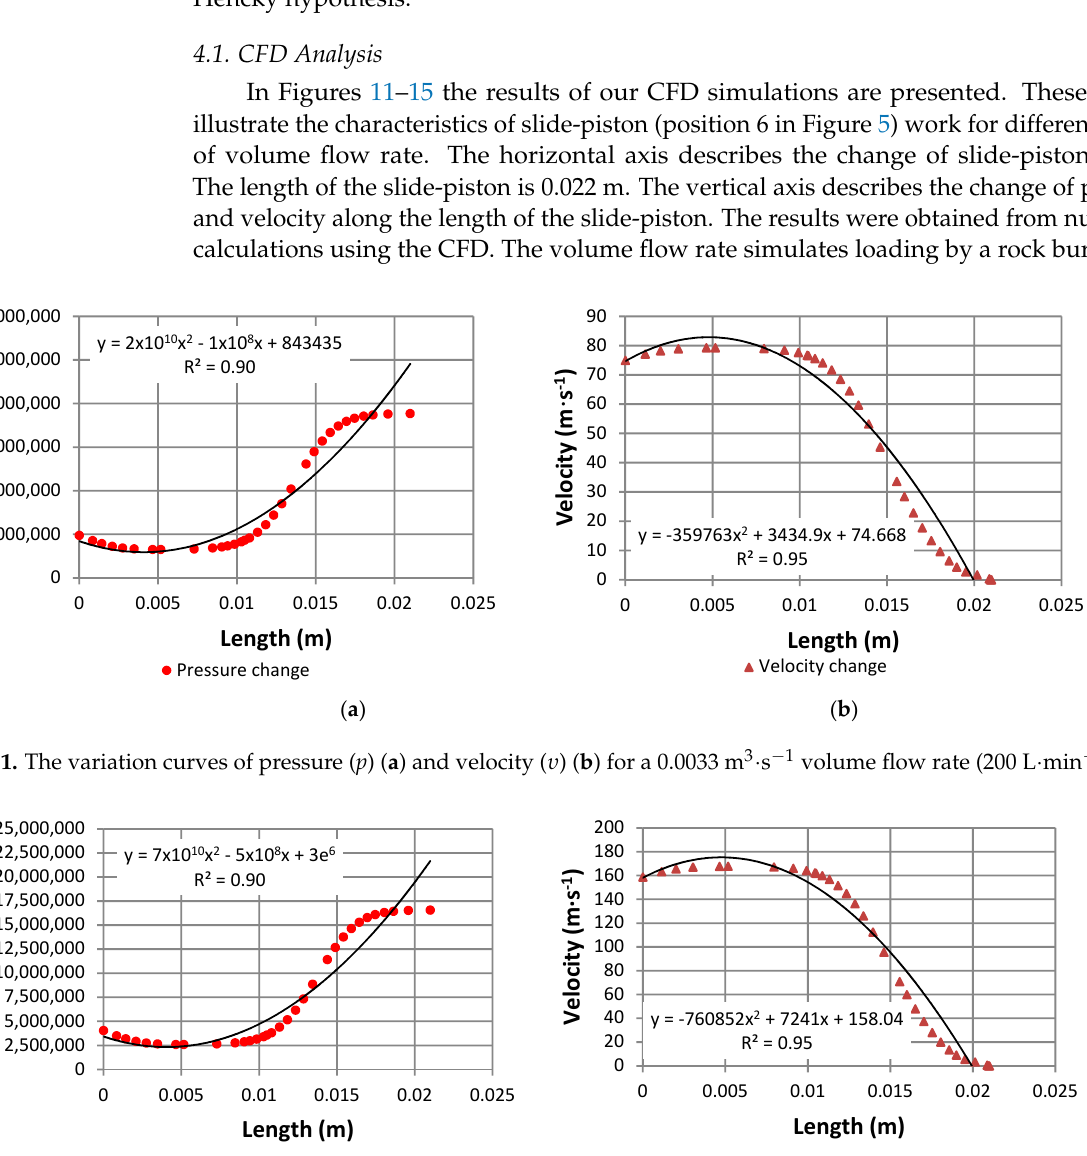
Figure 12. The variation curves of pressure ( p ) ( a ) and velocity ( υ ) ( b ) for a 0.007m 3 ·s -1 volume flow rate (420 L·min -1 ).